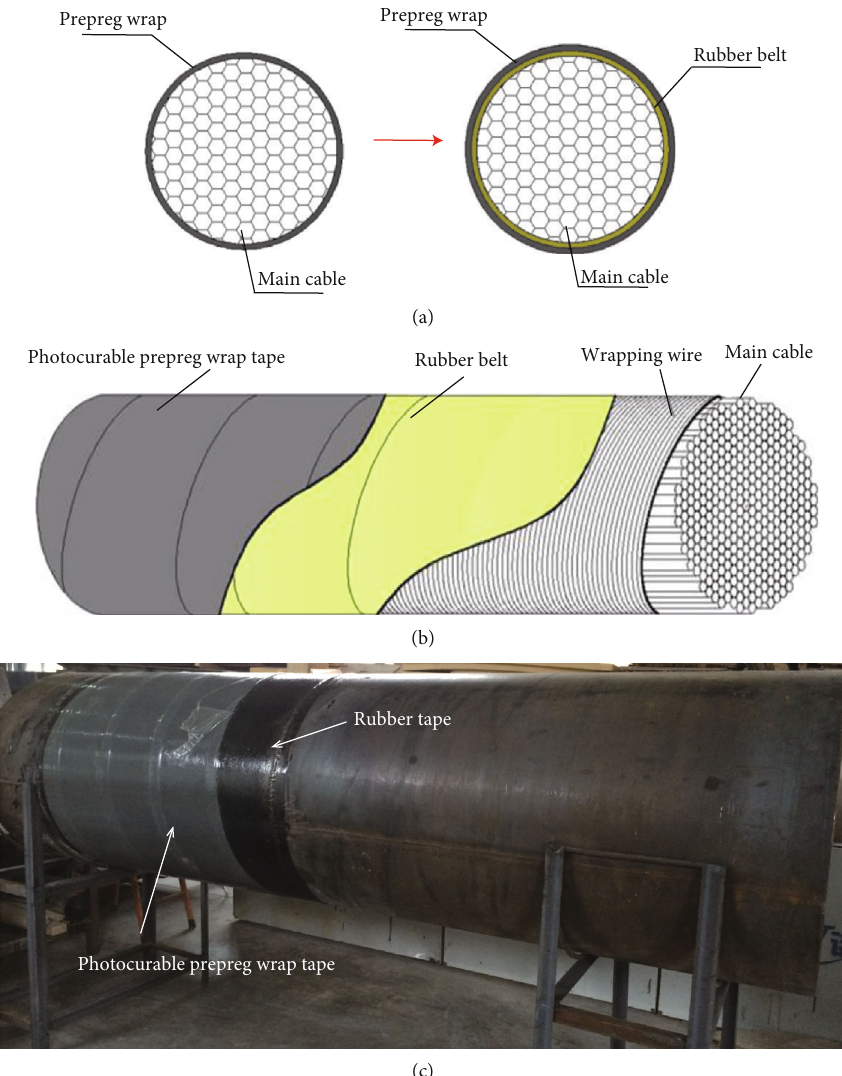
Figure 6: Schematic diagram of two samples: (a) section diagram of specimens, (b) structure diagram, and (c) actual